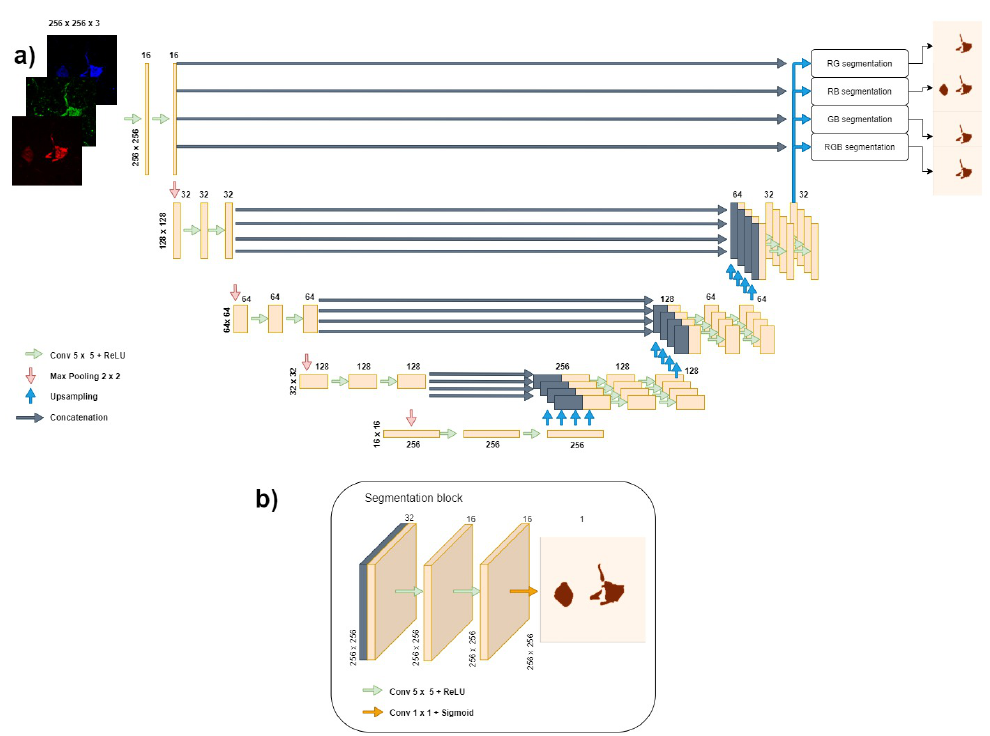
Figure 3. Proposed model of the extended semi-Siamese U-Net neural network. ( a ) The proposed model. Each box corresponds to a multi-channel feature map. The number of channels is denoted at the top of each box; the height and width of each feature map are provided at the edge of each box. The encoder path on the left consists of five levels (including the bottleneck at the bottom), each one consisting of two convolutional layers. The outputs of the encoder are concatenated with the upsampled feature maps in the decoder (gray arrows) before being passed through two additional convolutional layers. Each of the four decoding paths gets its own copy of the encoder feature map corresponding to its level. At the end of the network, there are four segmentation blocks. ( b ) The final segmentation block. At the end of the network, a 1 × 1 convolution is applied to obtain the final segmentation